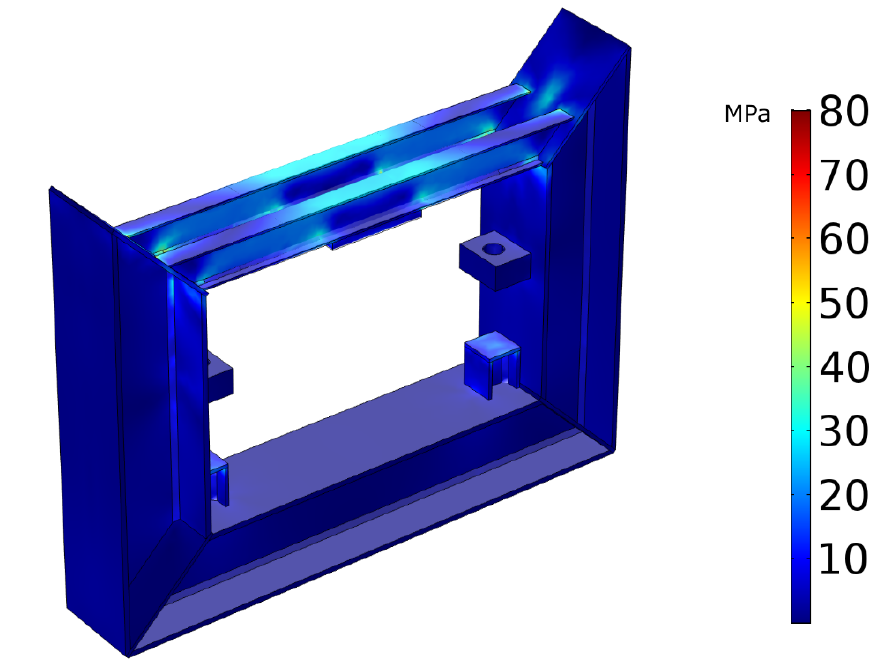
Figure 3. Stress distribution during 25 kN forces acting in all